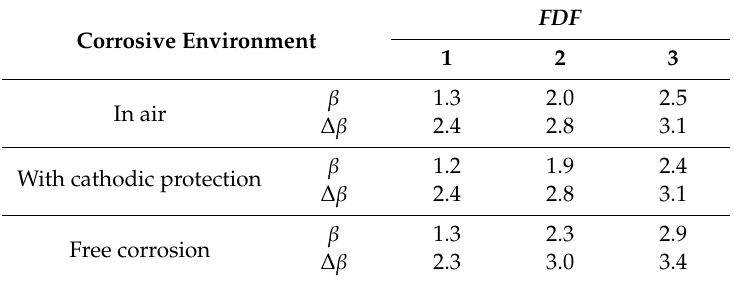
Table 4. Reliability indices in di ff erent corrosive